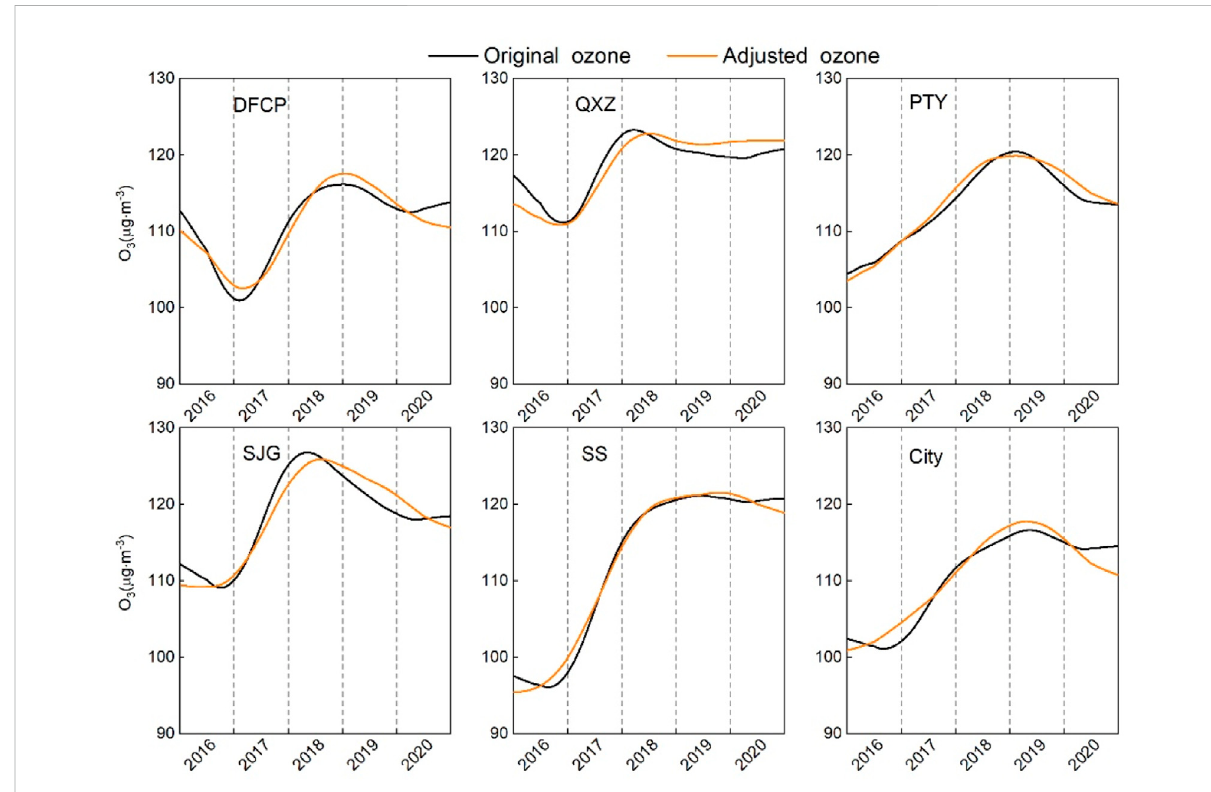
FIGURE 6 Variation in the ozone long-term component before and after meteorological adjustment. DFCP, Dongfeng Chemical Plant site, QXZ, Qixiangzhan, PTY, Putianyuan site, SJG, Sanjin Group site, SS, Shuangshan site and City: Zibo